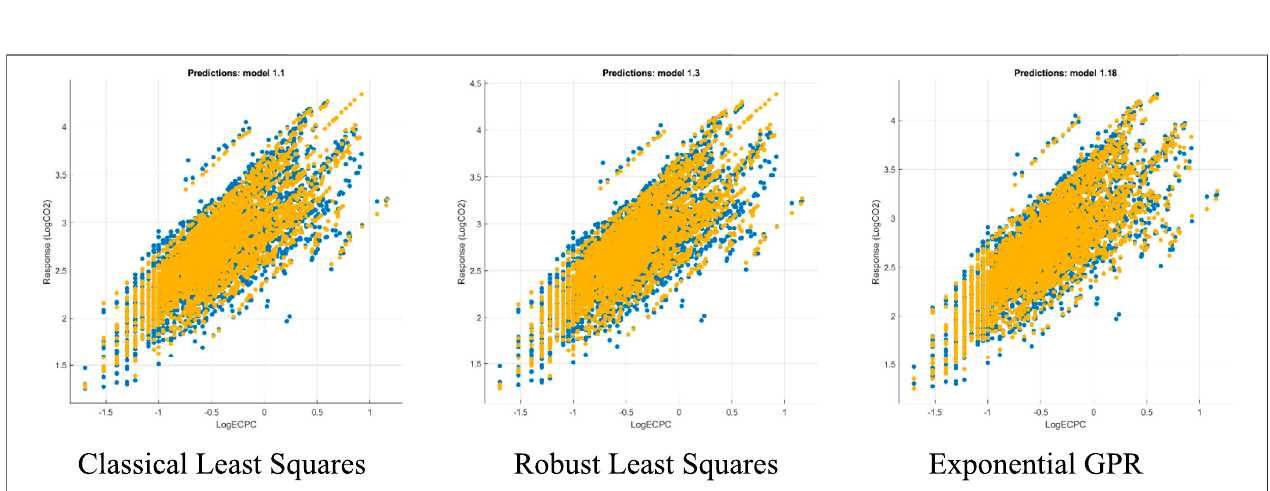
FIGURE5| Comparingactualandpredicted CO 2 emissionsagainstenergyconsumption oftheselectedmodels.ClassicalLeastSquares,RobustLeastSquares, Exponential GPR. Notes: 1) The vertical axis represents the value of CO 2 emissions in logarithm. 2) The horizontal axis represents the value of per capita energy consumptioninalogarithm.3)CO 2 emissionsaremeasuredin10,000 tonsofstandardcoal.4)Thebluedotsrepresentactualvalueswhereastheyellowdotsrepresent the predicted values. 5) Per capita energy consumption is measured in tons of standard